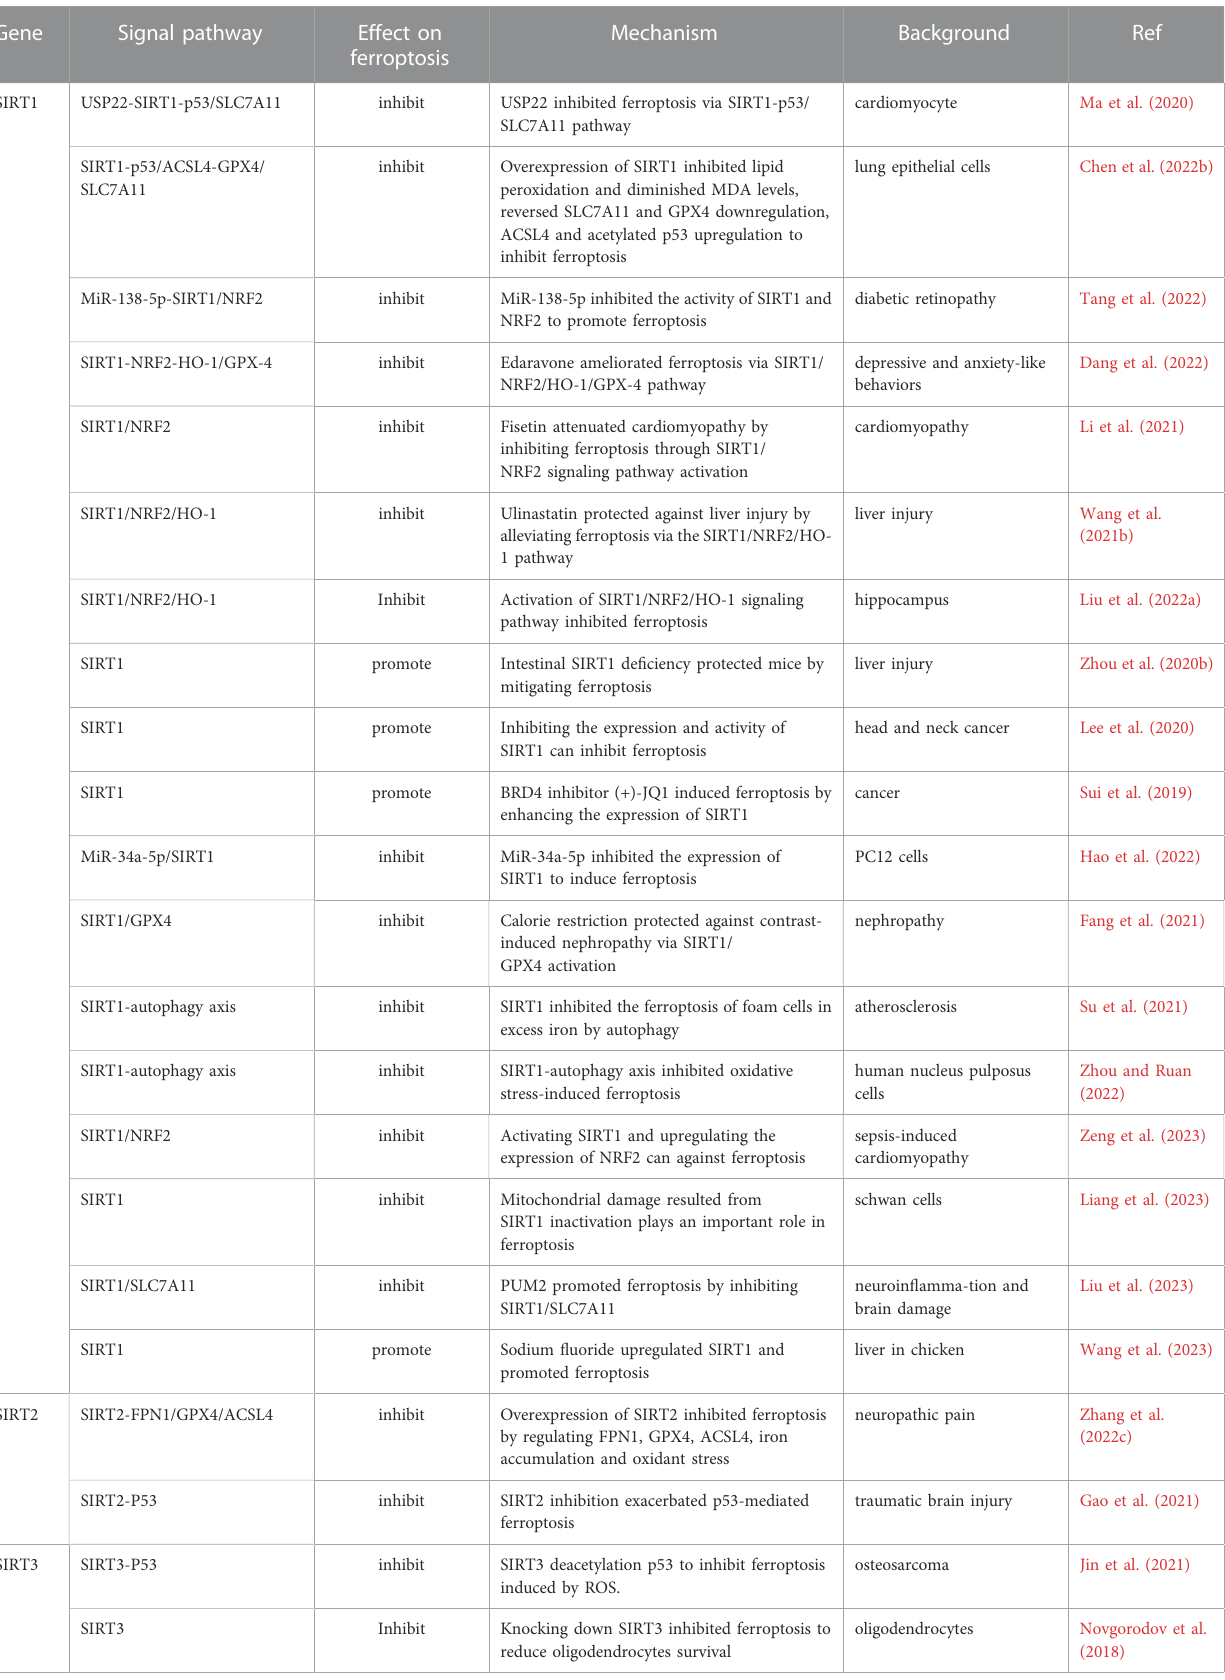
TABLE 2 The regulatory roles, molecular mechanisms, and research background of sirtuins in ferroptosis.